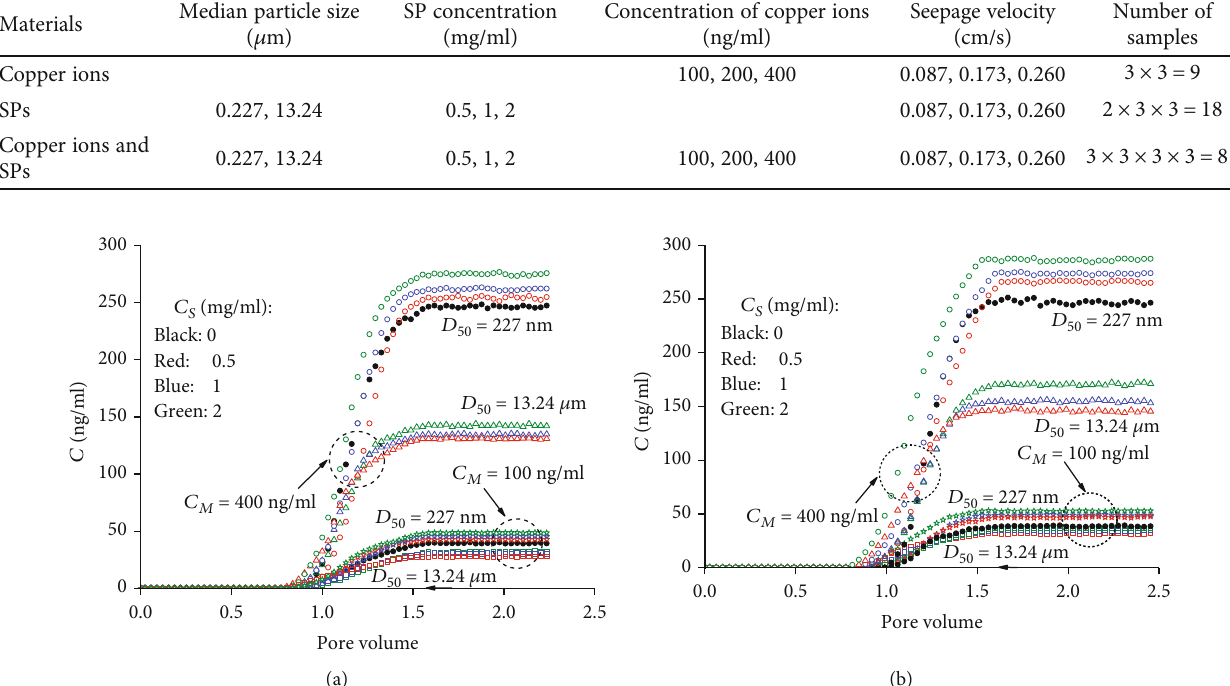
Figure 3: Penetration curves of copper ions at two seepage velocities: (a) v = 0 : 087cm/s and (b) v = 0 : 260 cm/s